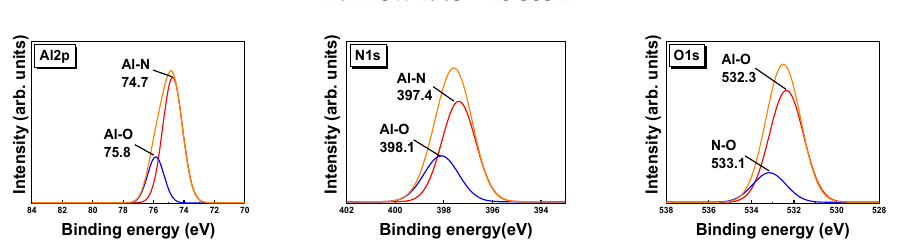
Figure 4. XPS core level spectra for Al, N, and O for various N 2 flow rates. Core level N 1s peaks were studied to understand the formation of AlN. The results reveal that the core level peak of N 1s was centered around 397 eV; the peaks around 397 eV were deconvoluted to investigate Al–N–O bonding. The centered peak is consistent with results in the literature [32,33]. The deconvoluted data reveal the formation of Al–N at 397.2, 397.3, and 397. 4 eV for N 2 flow rates of 20, 30, and 40 sccm, respectively. A weak peak was observed at 398.1 eV for Al–O [34–36]. The weak peak at 398.1 eV may also be due to surface oxidation.